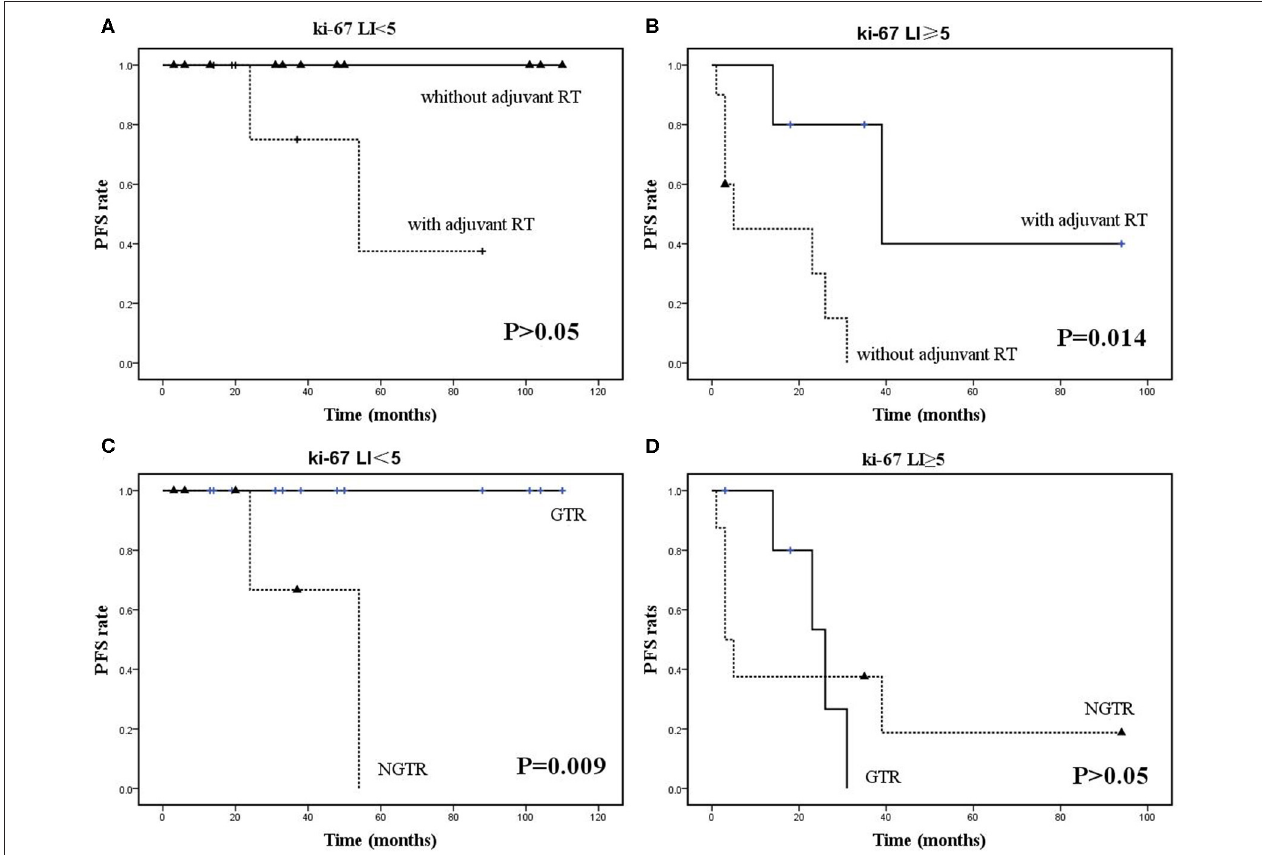
FIGURE 9 | Kaplan-Meier survival curves. (A,B) Adjuvant RT was significantly associated with longer PFS in the Ki-67 LI ≥ 5 group but not in the Ki-67 LI < 5 group. (C,D) GTR was significantly associated with longer PFS in the Ki-67 LI < 5 group but not in the Ki-67 LI ≥ 5 group.